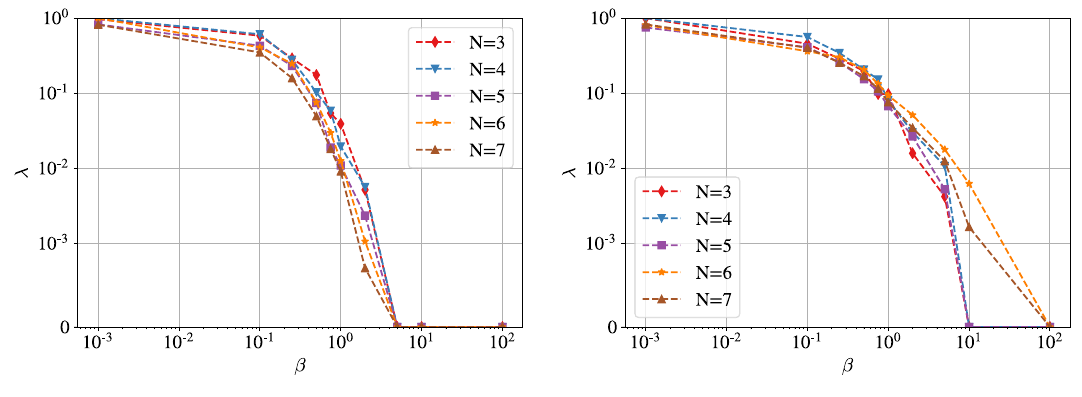
3 . We observe a clear decrease 0 for ≈